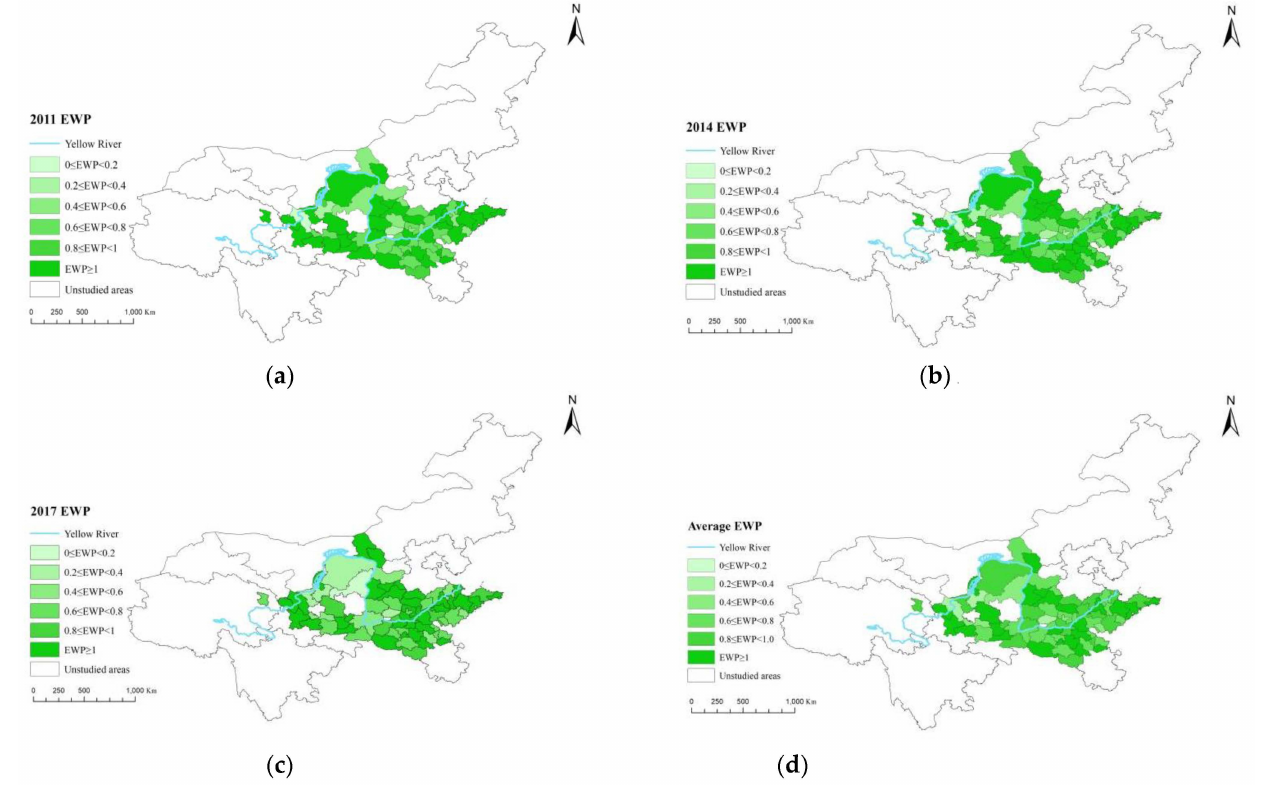
Figure 6. Spatial pattern of urban EWP in ( a ) 2011, ( b ) 2014, ( c ) 2017, and ( d )